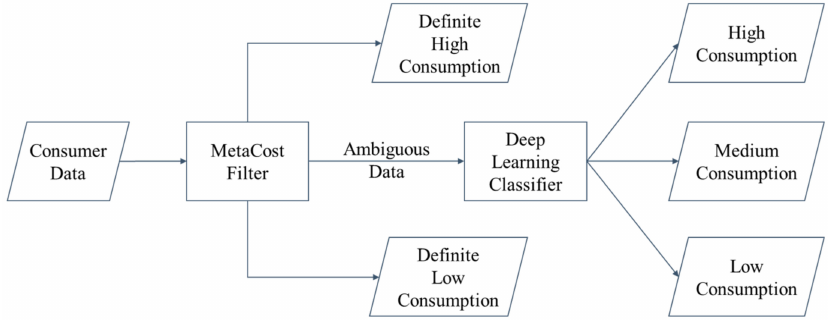
Figure 4. Proposed framework.